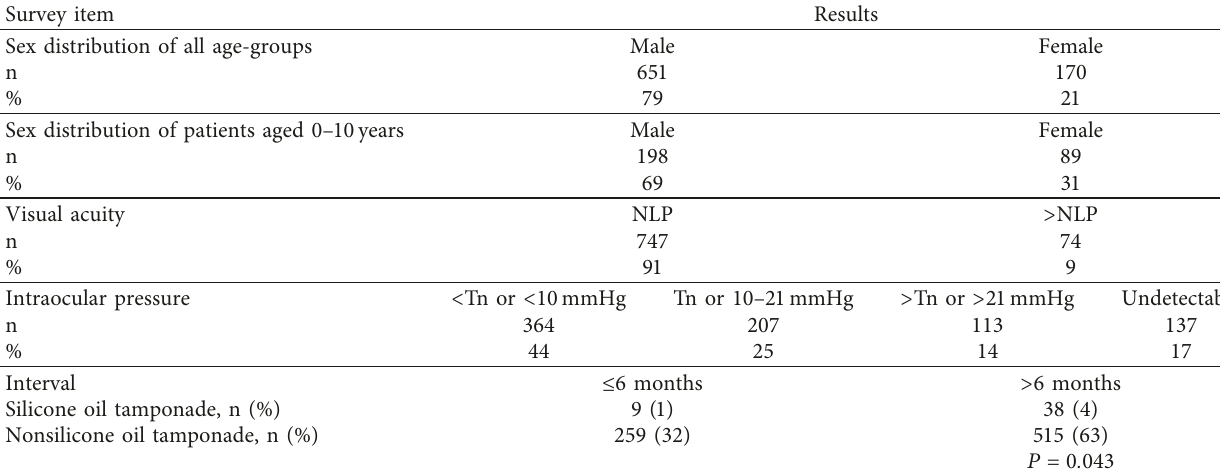
Table 1: Demographic data and ocular features of the patients.